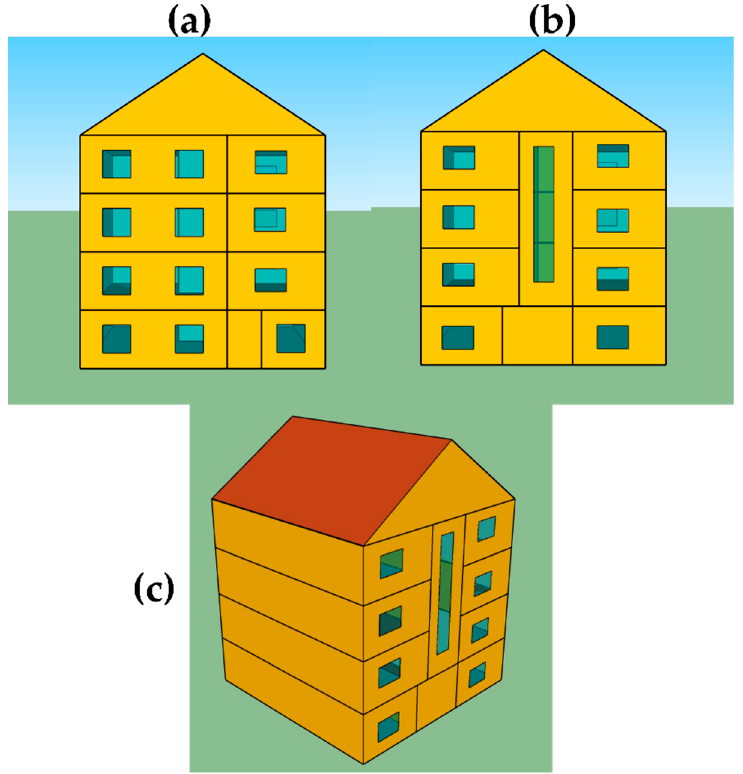
Figure 3. ( a ) Front, ( b ) back, and ( c ) isometric view of modelled tenement.